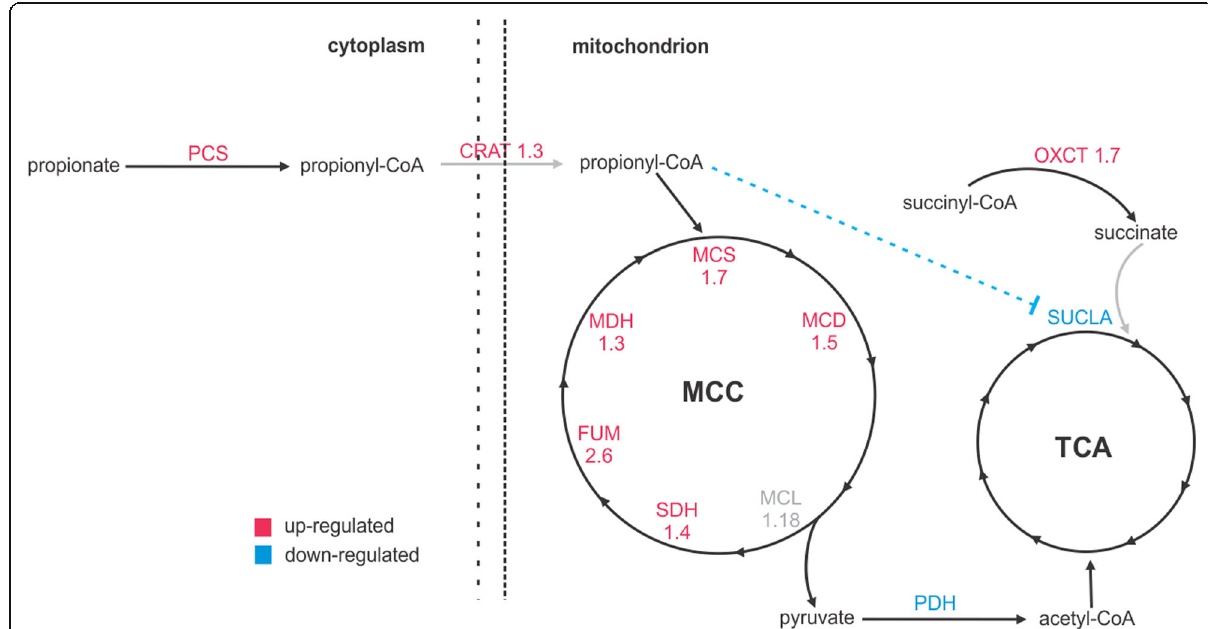
Fig. 7 Metabolic processes specifically related to propionyl-CoA turnover. MCS methylcitrate synthase, MCD methylcitrate dehydratase, MCL